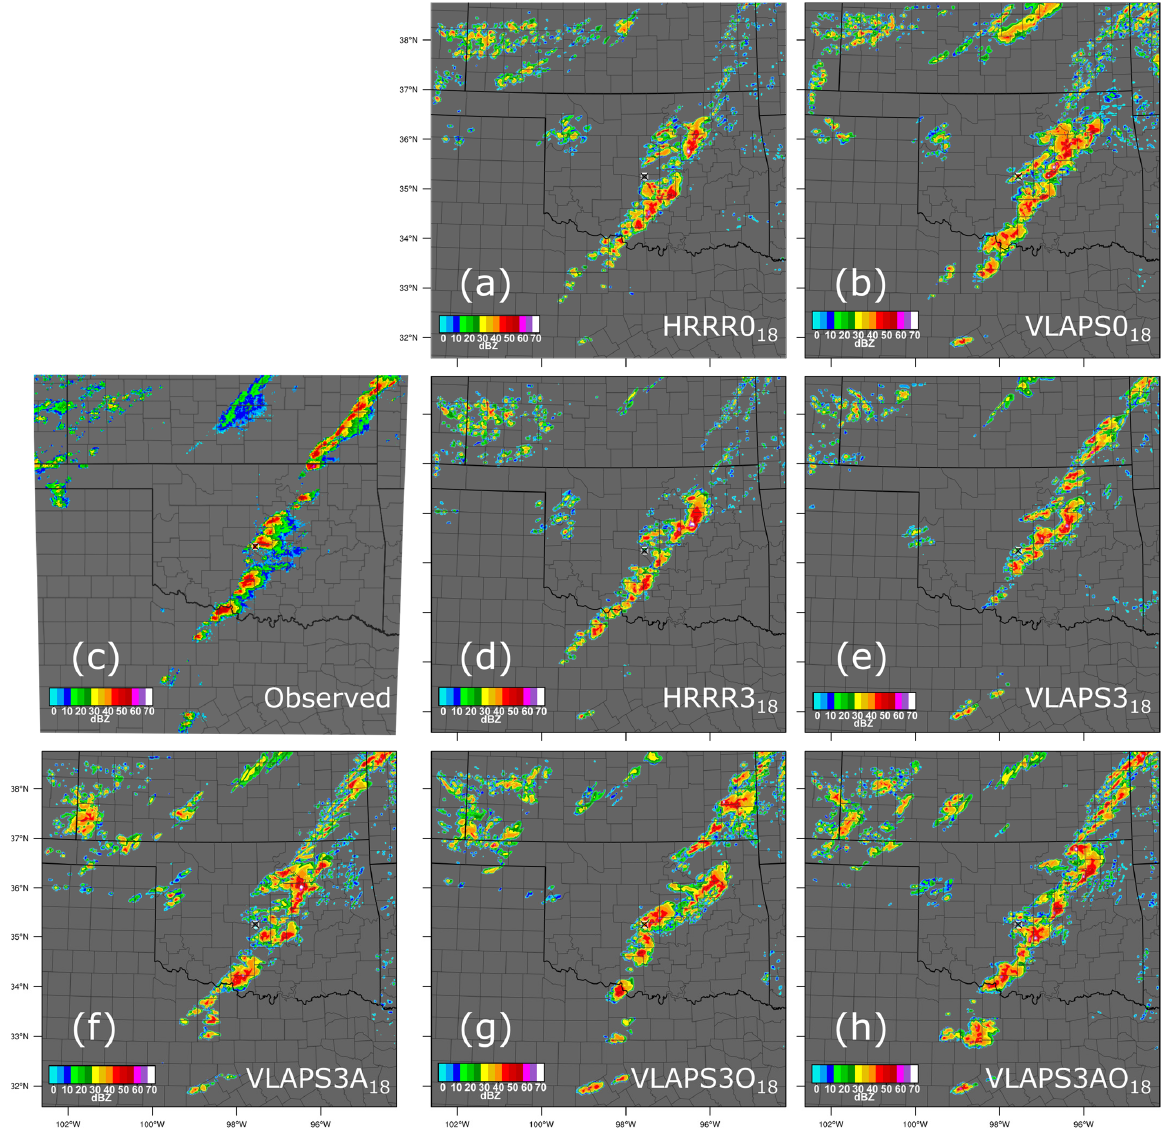
Figure 6. Reflectivity at 2015 UTC on 20 May 2013 from ( a ) HRRR0 18 ; ( b ) VLAPS0 18 ; ( c ) observations; ( d ) HRRR3 18 ; ( e ) VLAPS3 18 ; ( f ) VLAPS3A 18 ; ( g ) VLAPS3O 18 ; ( h ) VLAPS3AO 18 . The black X within the white square shows the approximate location of the EF5 tornado. The observed reflectivity is the composite base reflectivity, and the WRF-ARW reflectivity is the lowest model-level radar reflectiv- ity.